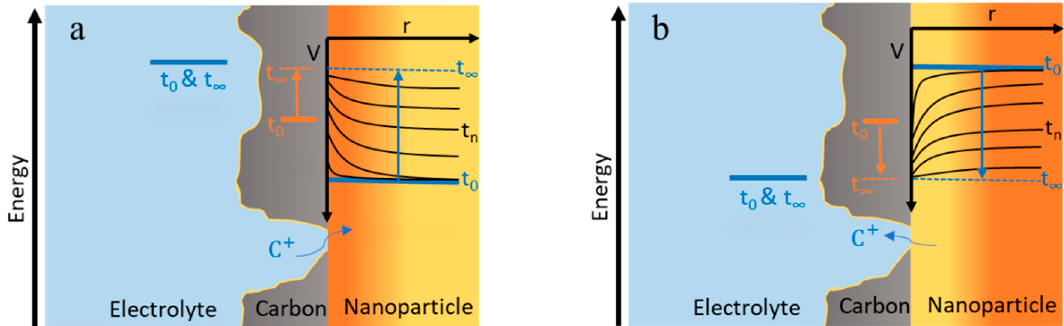
Figure 9. Equilibration of the Fermi level of the redox solid nanoparticle with a diffusion controlled profile during: ( a ) charging the nanoparticle when it shifts from a lower initial energy level than that of the electrolyte ( t 0 ) to the fixed Fermi level of the electrolyte at equilibrium ( t ∞ ); ( b ) discharging the nanoparticle when it lowers from a higher initial energy level ( t 0 ) to the fixed Fermi level of the electrolyte at equilibrium ( t ∞ ). The Fermi level of the carbon always locates between the Fermi level of the electrolyte and the redox solid. At equilibrium ( t ∞ ), all Fermi levels are located at the fixed Fermi level of the electrolyte.